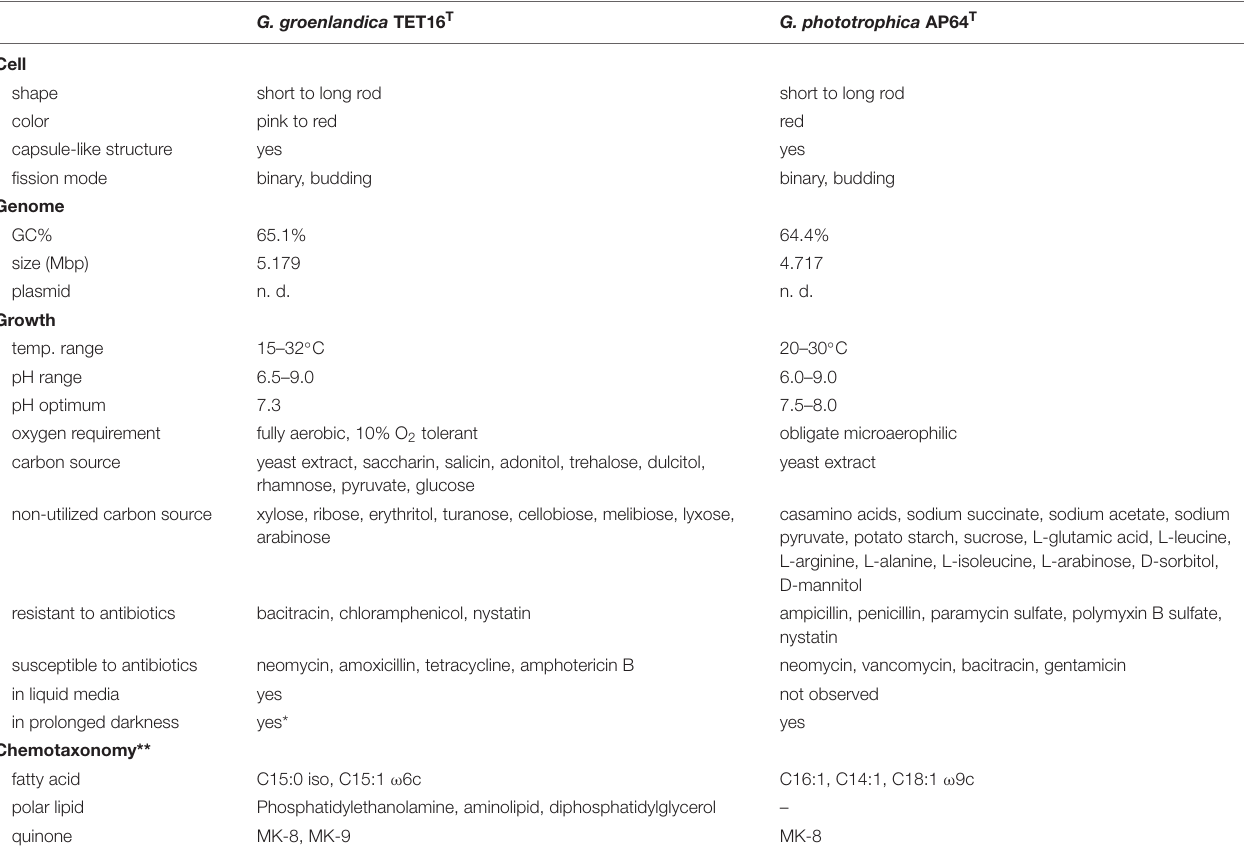
TABLE 1 | Comparison of phenotypic, physiological and genomic characteristics of the two phototrophic members in the phylum Gemmatimonadetes, Gemmatimonas groenlandica strain TET16 T and Gemmatimonas phototrophica strain AP64 T